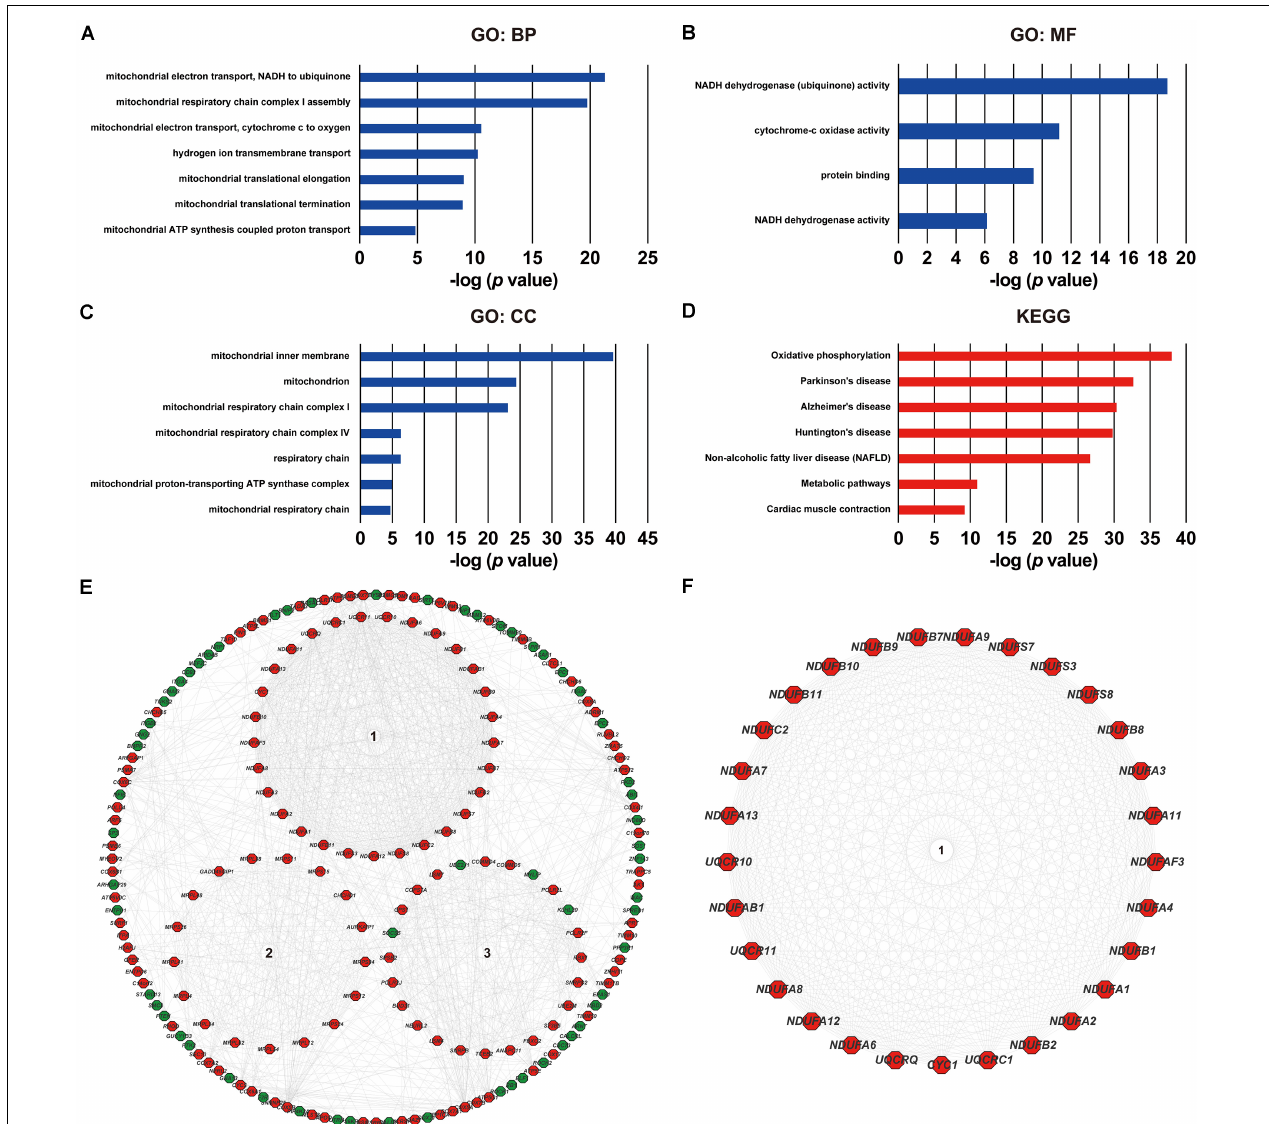
FIGURE 6 | Functional analyses of ACOT8 by GO, KEGG pathway and PPI network. GO functional enrichment analysis comprising biological process (BP, A ), molecular function (MF, B ) and cellular component (CC, C ), as well as KEGG pathway analysis (D) were performed on ACOT8 co-expressed genes in TCGA KIRC dataset. These co-expressed genes were further utilized to construct a PPI network by Cytoscape software, and the top three hub gene clusters are shown in the form of circle in the middle of (E) . Positive-related genes are shown in red, while negative-related genes in green. The gene cluster with the highest score of connectivity is separately presented in (F)